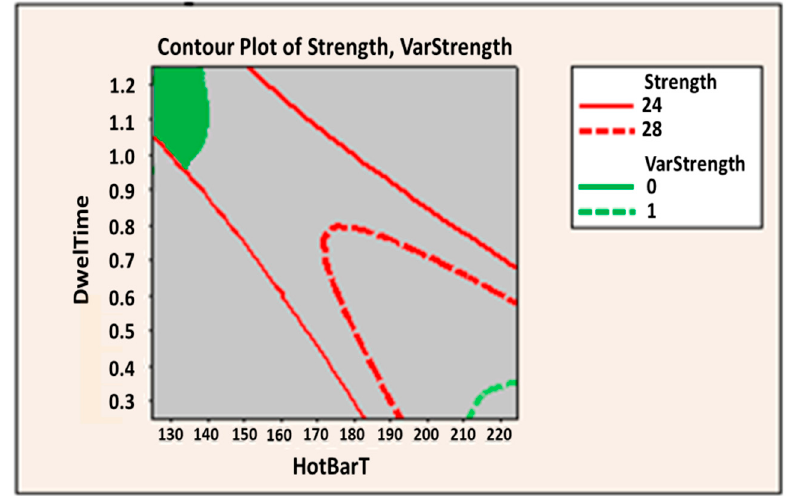
Figure 1. Two responses variables contour plot.